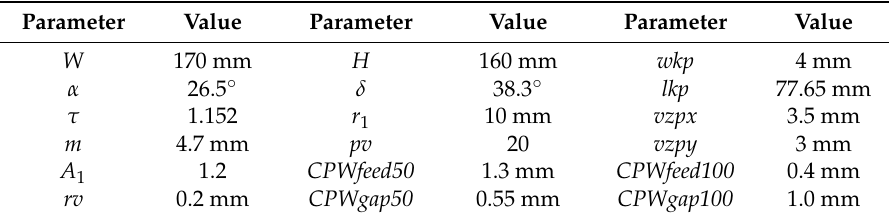
Table 2. The resulting parameters of the manufactured antenna with coplanar waveguide with ground (CPWG)